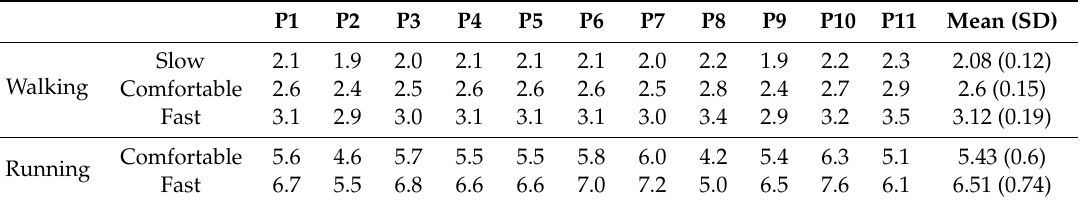
Table 2. Walking and running speeds used in the experiment for each participant (PX is an abbreviation for participant number, units are km / h, and SD is an abbreviation for standard